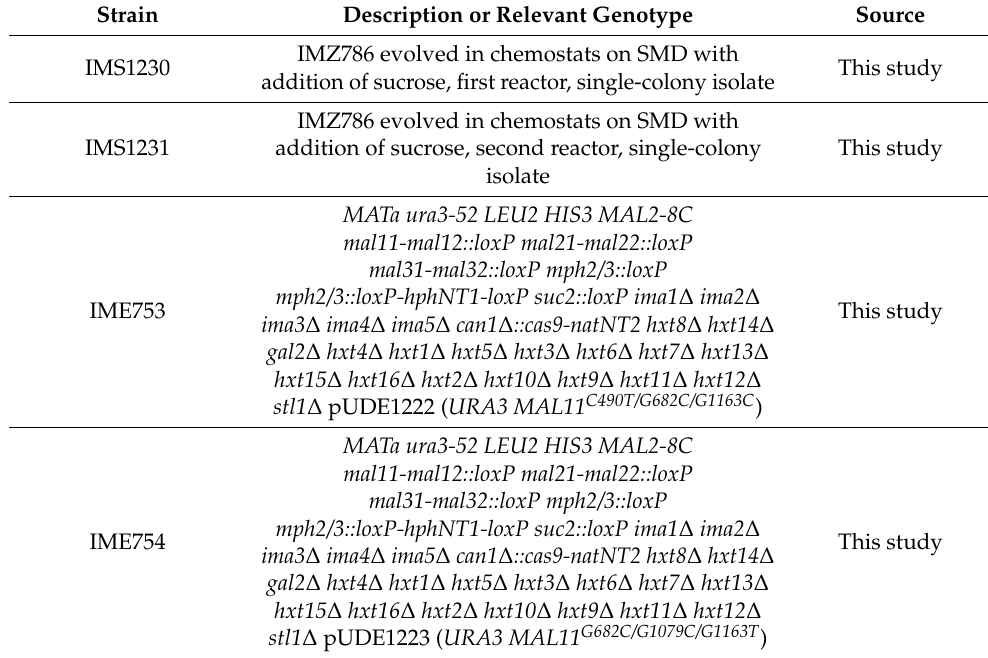
Table 1. Cont. Strain Description or Relevant Genotype Source IMZ786 evolved in chemostats on SMD with IMS1230